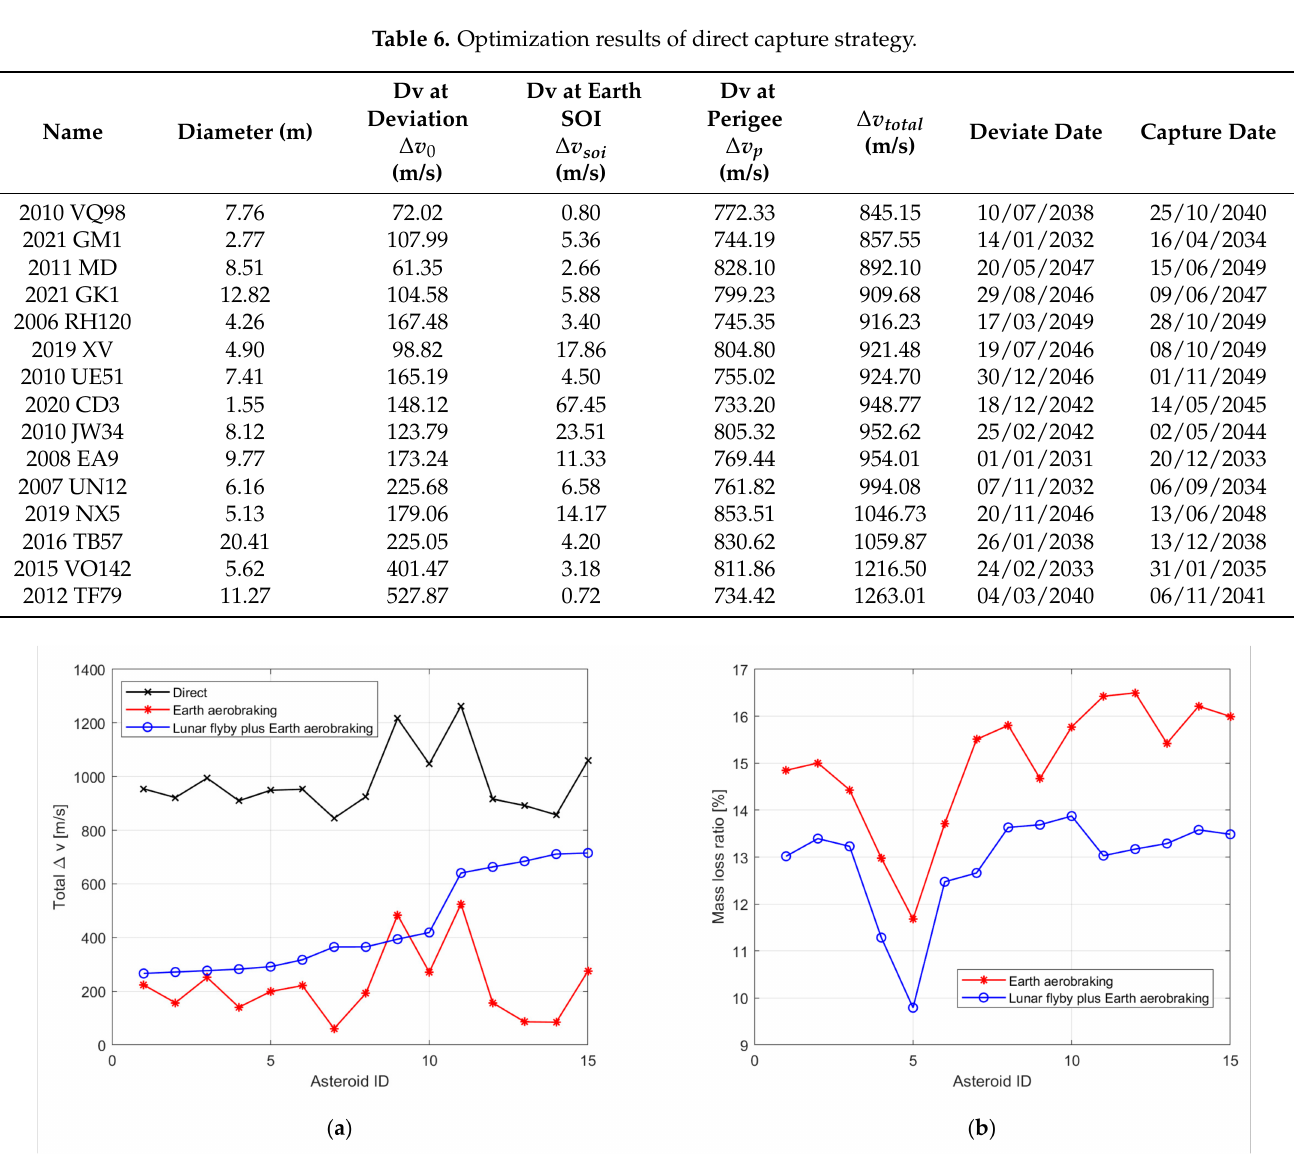
Figure 3. Differences in total delta-v and mass loss ratio between different capture strategies; ( a ) The differences in total delta-v; ( b ) The differences in total mass loss